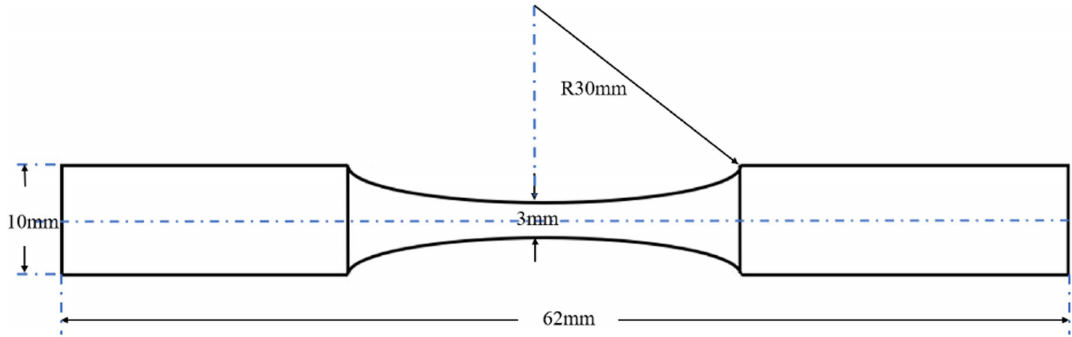
Figure 10. Shape and size of a specimen for fatigue test.